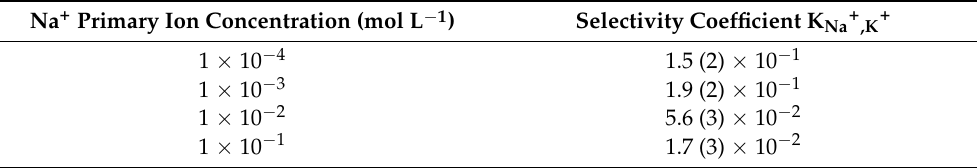
Table 3. Selectivity coefficients of Na + -ISE based on (NaI) 15 (Ga 2 S 3 ) 23 (GeS 2 ) 62 glass membrane with respect to the interfering ions K + . The measurements were conducted using a constant concentration of Na + ions 1 .